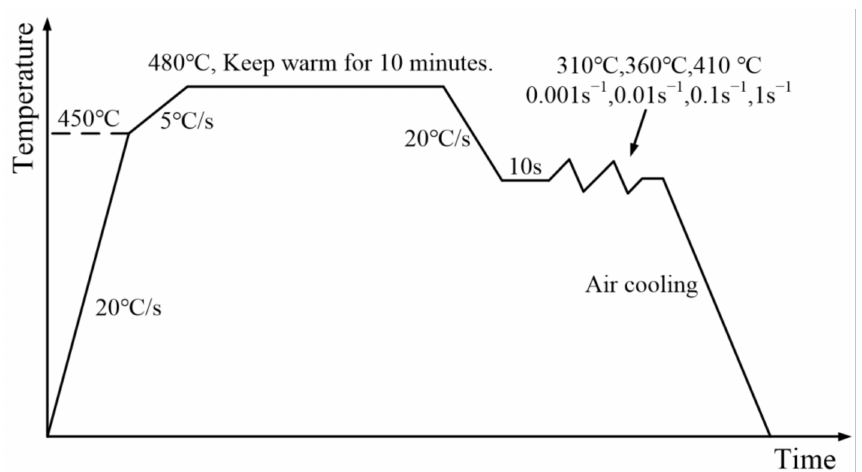
Figure 3. Sample temperature history.